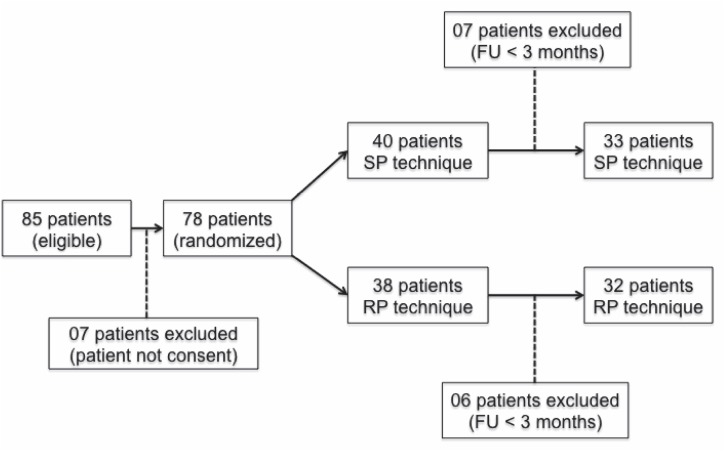
Study Flowchart.